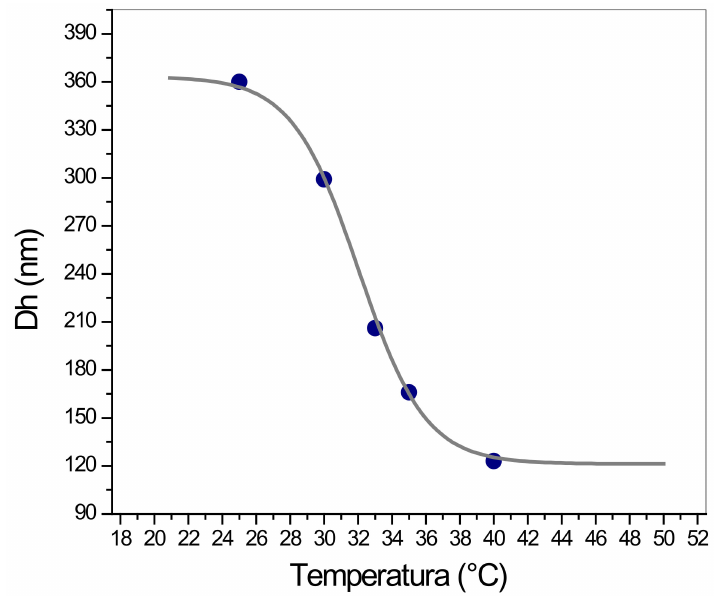
Figure 6. Effect of temperature on the hydrodynamic radius (measured by DLS) of cross-linked P(NIPAM-co-2%AMPS)